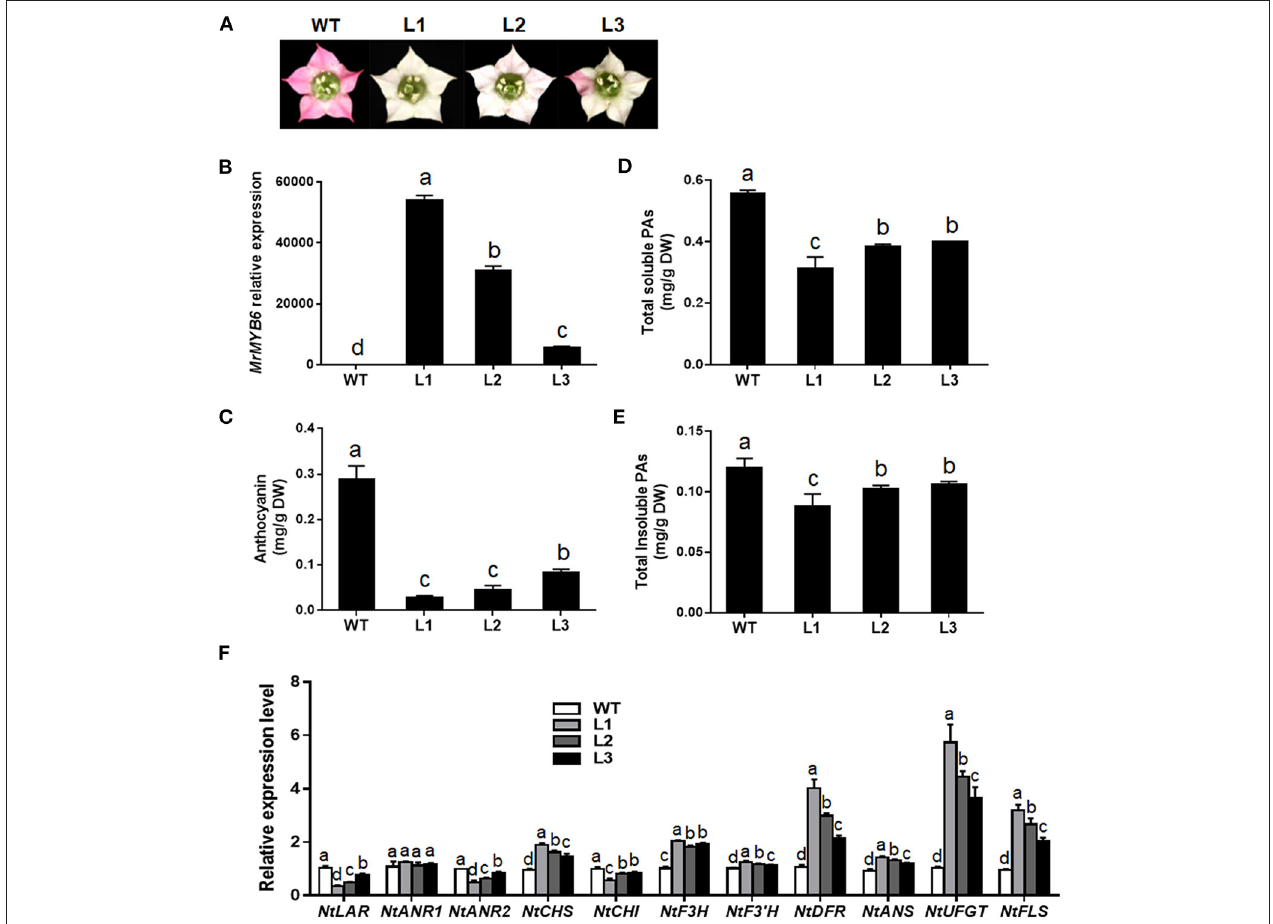
FIGURE 2 | Ectopic expression of MrMYB6 gene in tobacco. (A) Comparison of flower color in wild type (WT) and three MrMYB6 transgenic (L1, L2, and L3) tobacco lines. (B) Relative expression levels of MrMYB6 in transgenic flowers. The data were normalized using the WT sample and the NtACTIN (GQ339768) gene as the internal controls and calculated using the 2 − 11 Ct method. (C) Anthocyanin content in flowers of WT and three MrMYB6 tobacco lines. (D) Total soluble PAs levels of WT and transgenic flowers. (E) Total insoluble PAs levels of WT and transgenic flowers. (F) Expression analysis of flavonoid biosynthetic genes in flowers of MrMYB6 transgenic tobacco. Error bars indicate the mean ± SE of three replicate reactions. Letters (a, b, c, and d) represent significant difference between wild-type and transgenic plants according to the Duncan’s multiple range test ( P <